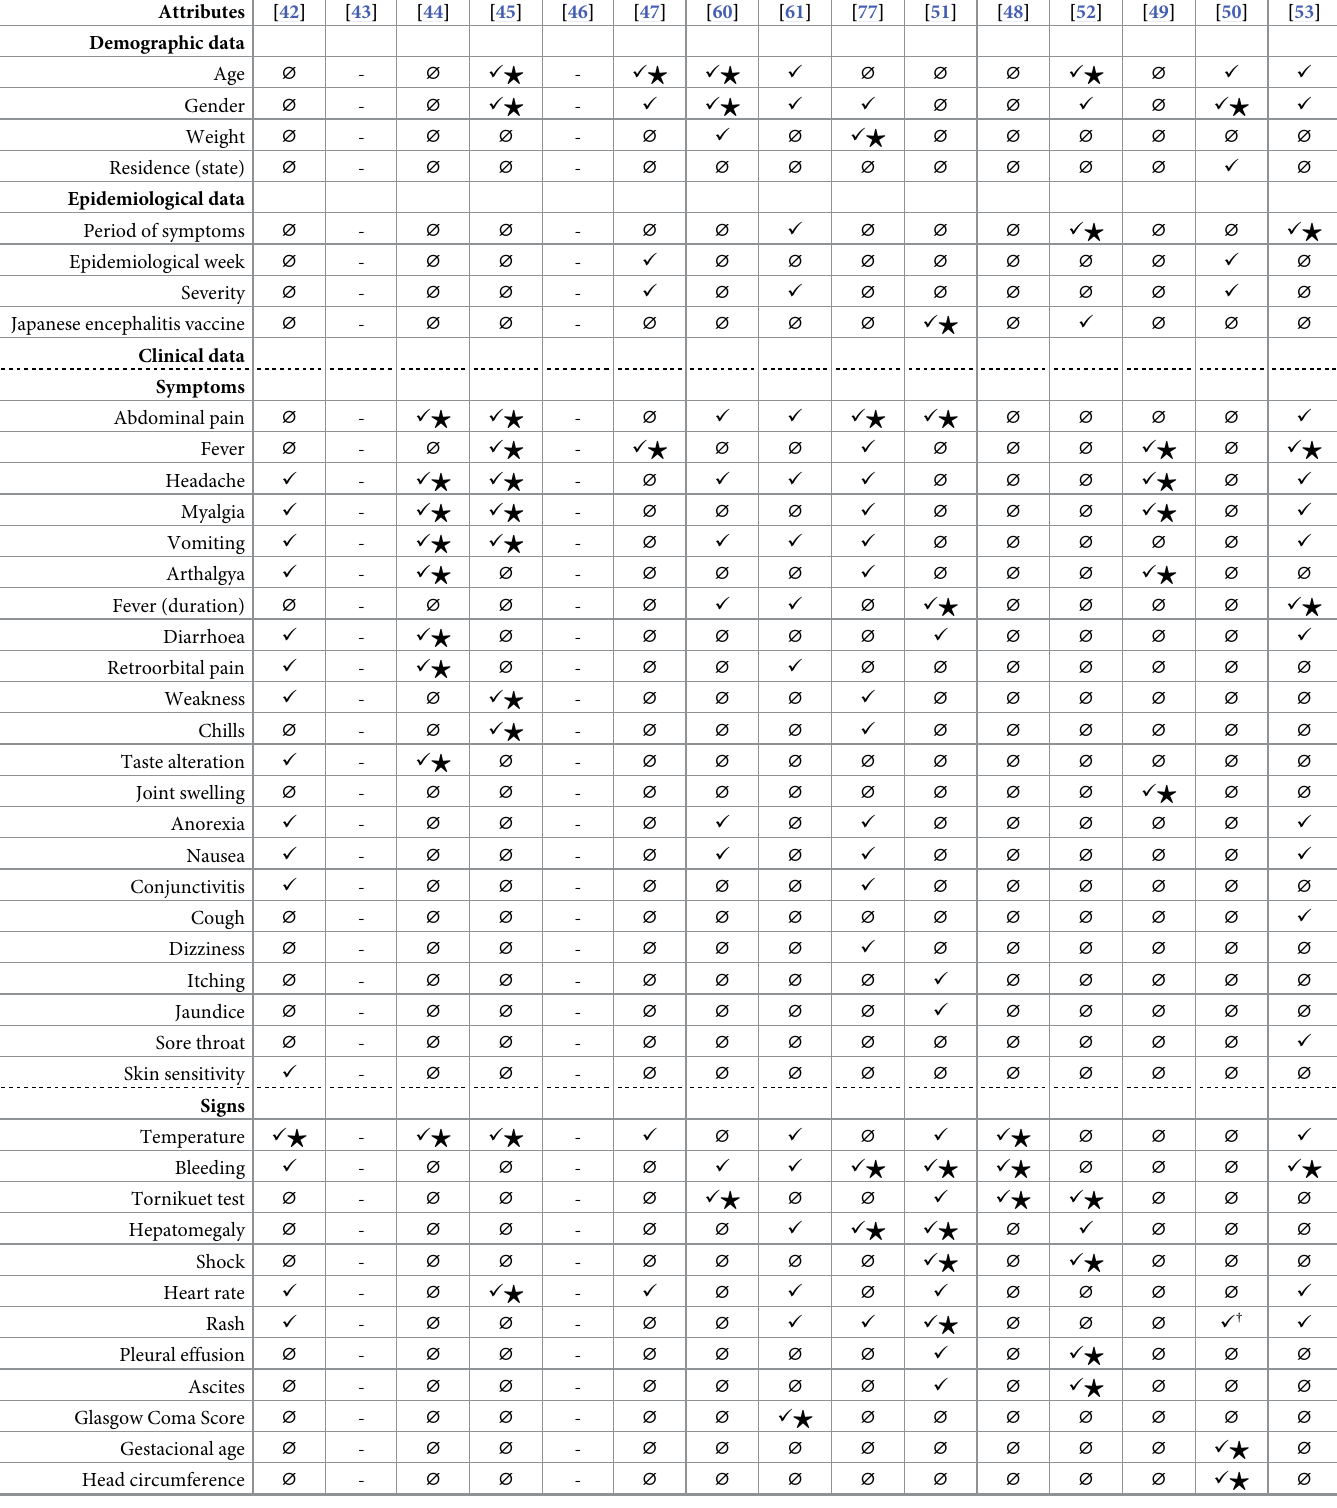
Table 4. Summary of all demographic, epidemiological and clinical data presented in data set used by the primary studies.